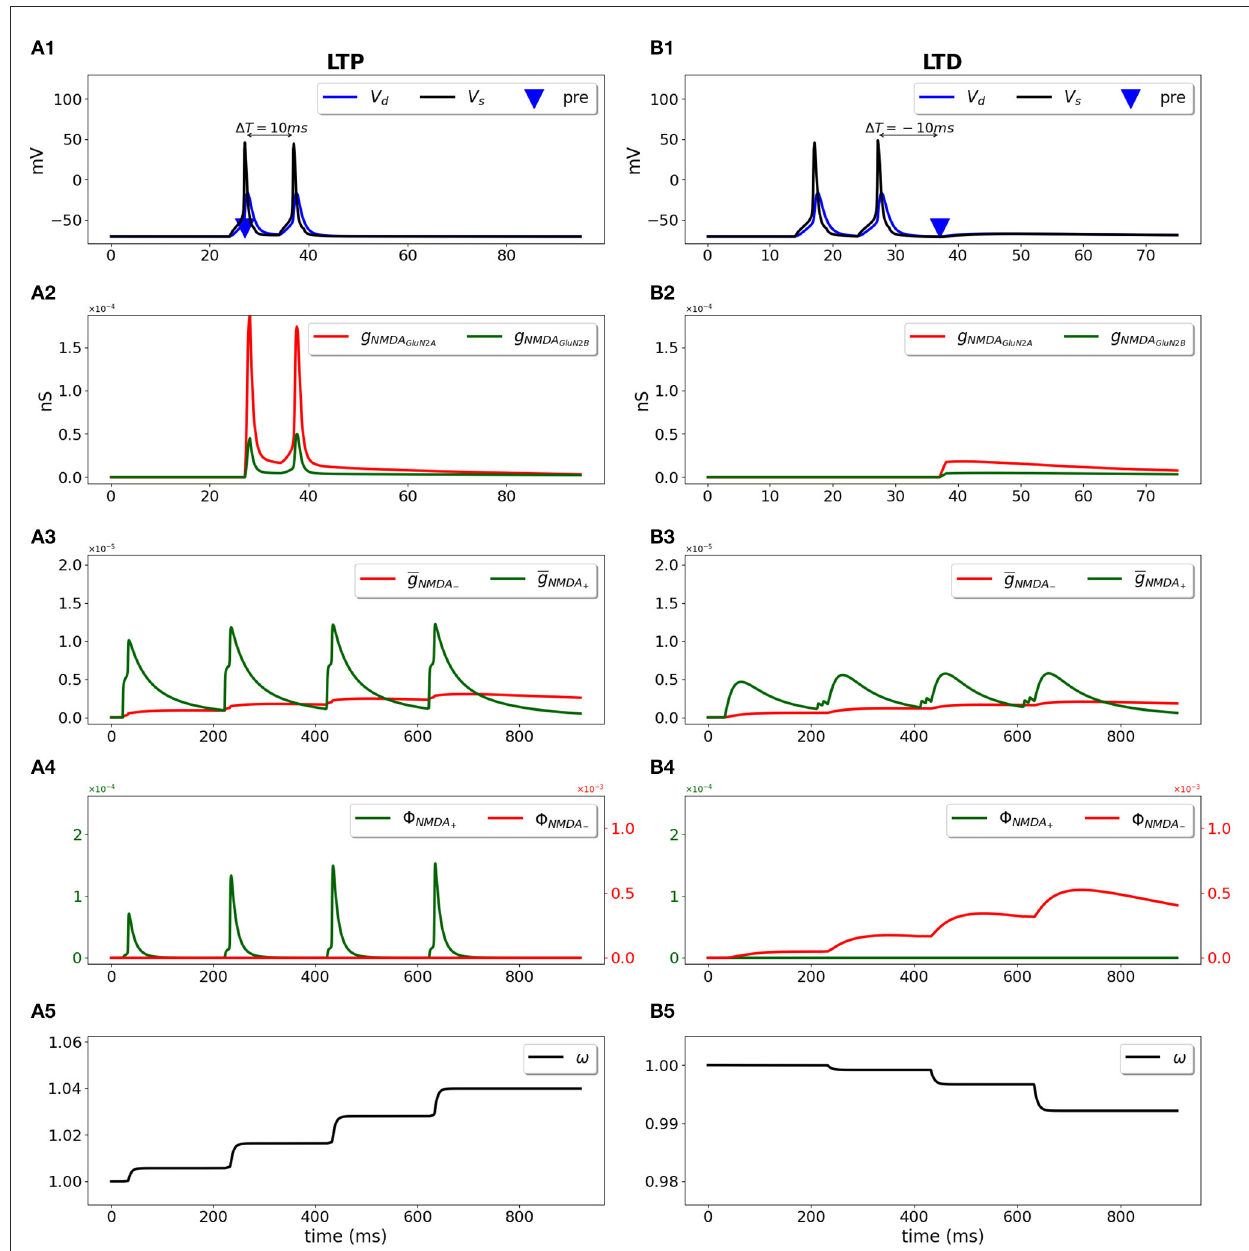
FIGURE2 Synaptic weight change for the STDP induction protocol using a two-compartment model of CA1 pyramidal neuron. Presynaptic input was paired with a doublet of postsynaptic action potentials with the temporal difference between pre- and a second postsynaptic activity 1 T = 10 ms (A1–A5) and 1 T = -10 ms (B1–B5) . (A1, B1) Membrane potential in soma V s (black line) and dendrite V d (blue line); presynaptic input is indicated by a blue triangle; (A2, B2) GluN2A-NMDAR and GluN2B-NMDAR conductances g NMDA (red line) and g NMDA (green line); (A3, B3) filtered GluN 2 A GluN 2 B NMDAR-dependent variables g NMDA (red) and g NMDA (green) for LTD and LTP; (A4, B4) NMDAR-dependent functions φ NMDA − (red line) and φ NMDA + − + (green line) for the LTD and LTP components; (A5, B5) synaptic weight w